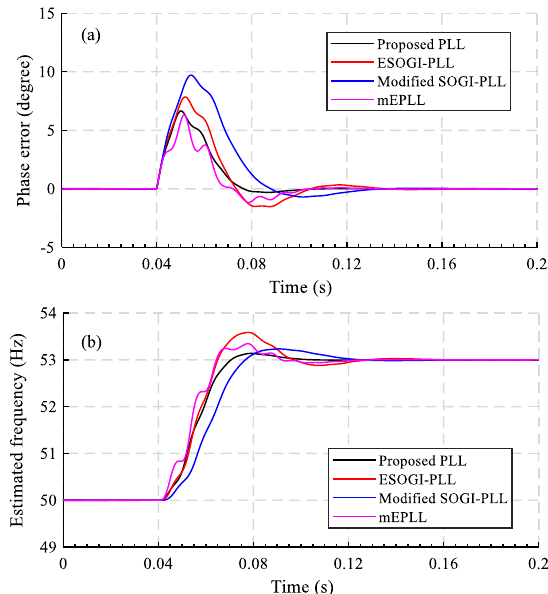
Fig. 7 Performance comparison between the proposed PLL, ESOGI-PLL, modified SOGI-PLL, and mEPLL under Case 1 (a phase jump of 20° at 0.04 s). a Estimated phase error and b estimated grid frequency